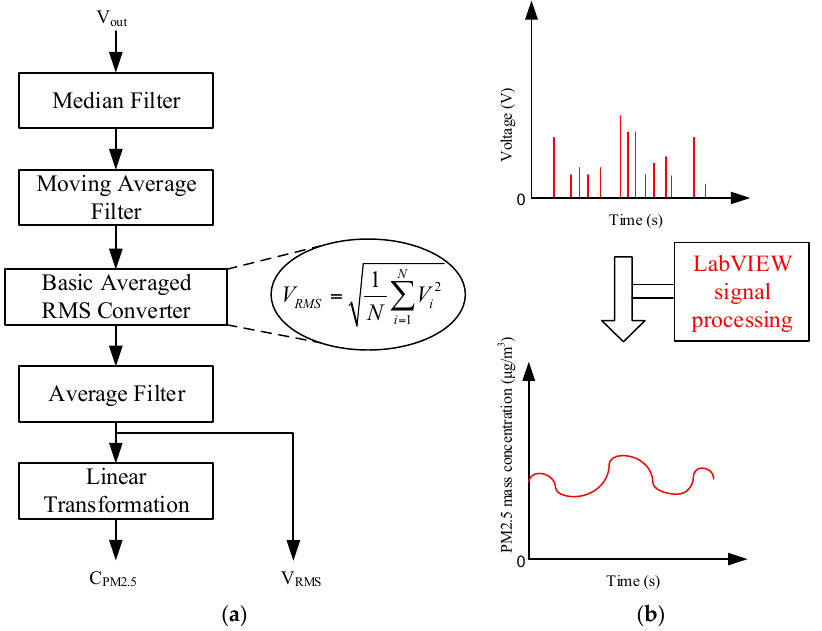
Figure 4. Schematic diagram of software signal processing: ( a ) flow diagram; ( b ) waveforms.